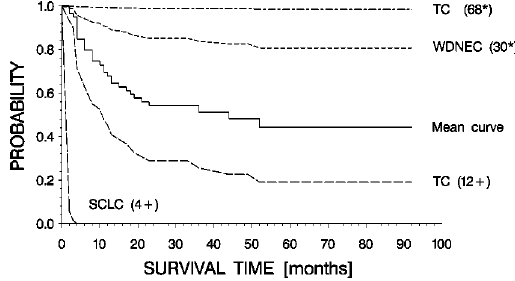
Fig. 6. Individual survival curves for four patients according to the Cox regression analysis and mean survival curve for all patients ( ? patient still alive, + patient